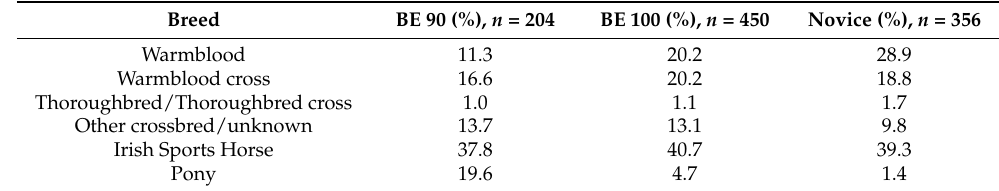
Table 2. The proportion of breeds as a percentage of competition starts at 34 British Eventing (BE) 90, 100 and Novice competitions.